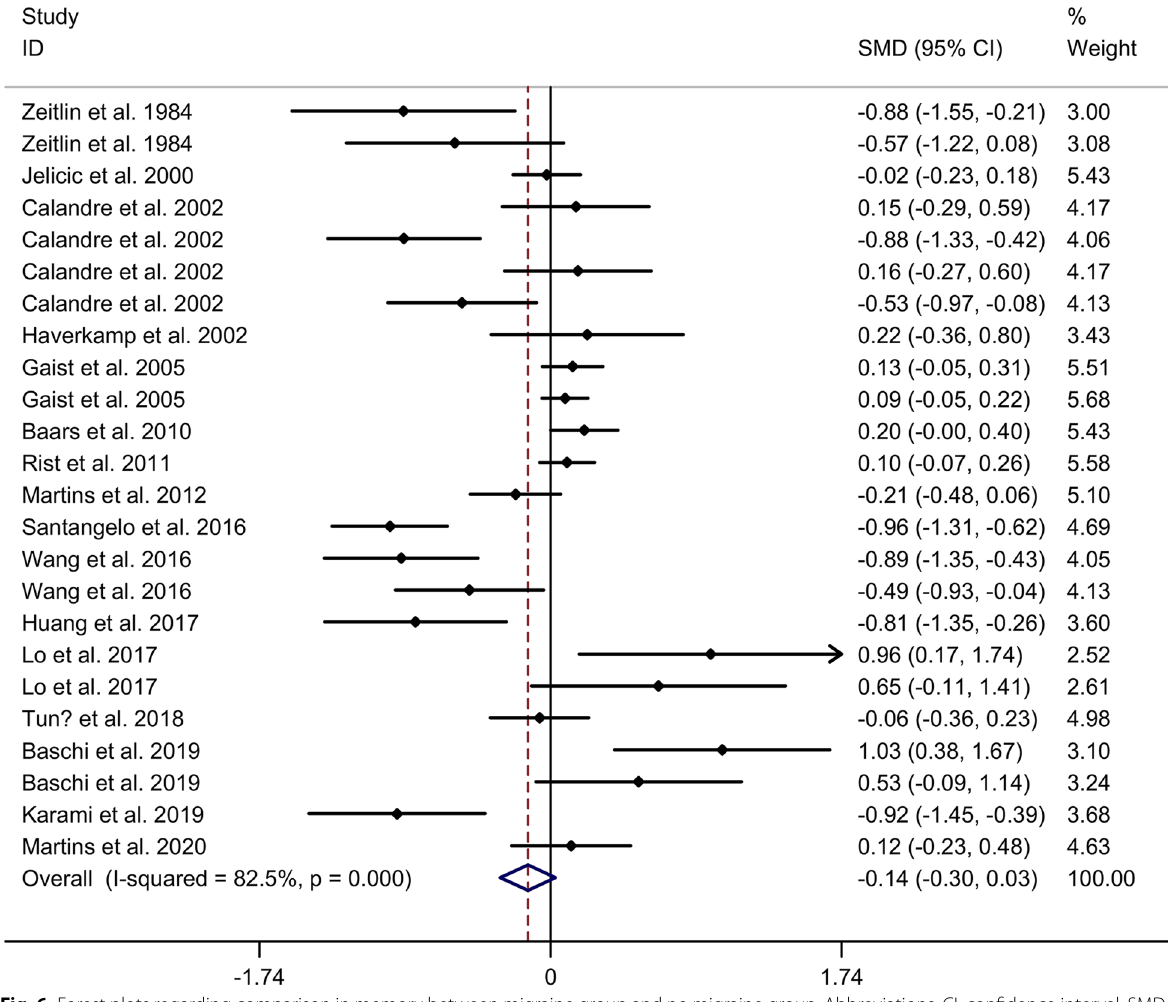
Fig. 6 Forest plots regarding comparison in memory between migraine group and no migraine group. Abbreviations: CI, confidence interval; SMD, standard mean